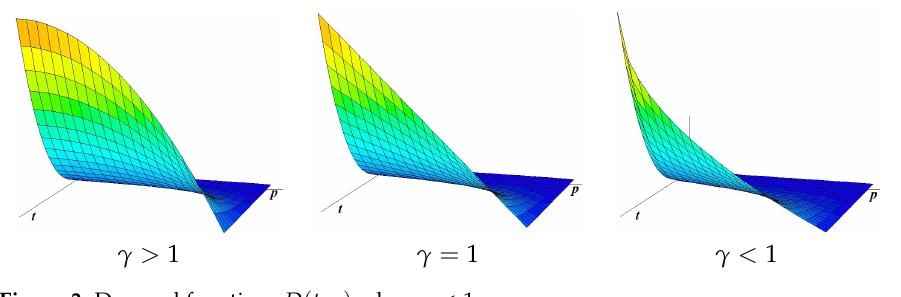
Figure 3. Demand functions D ( t , p ) when n <